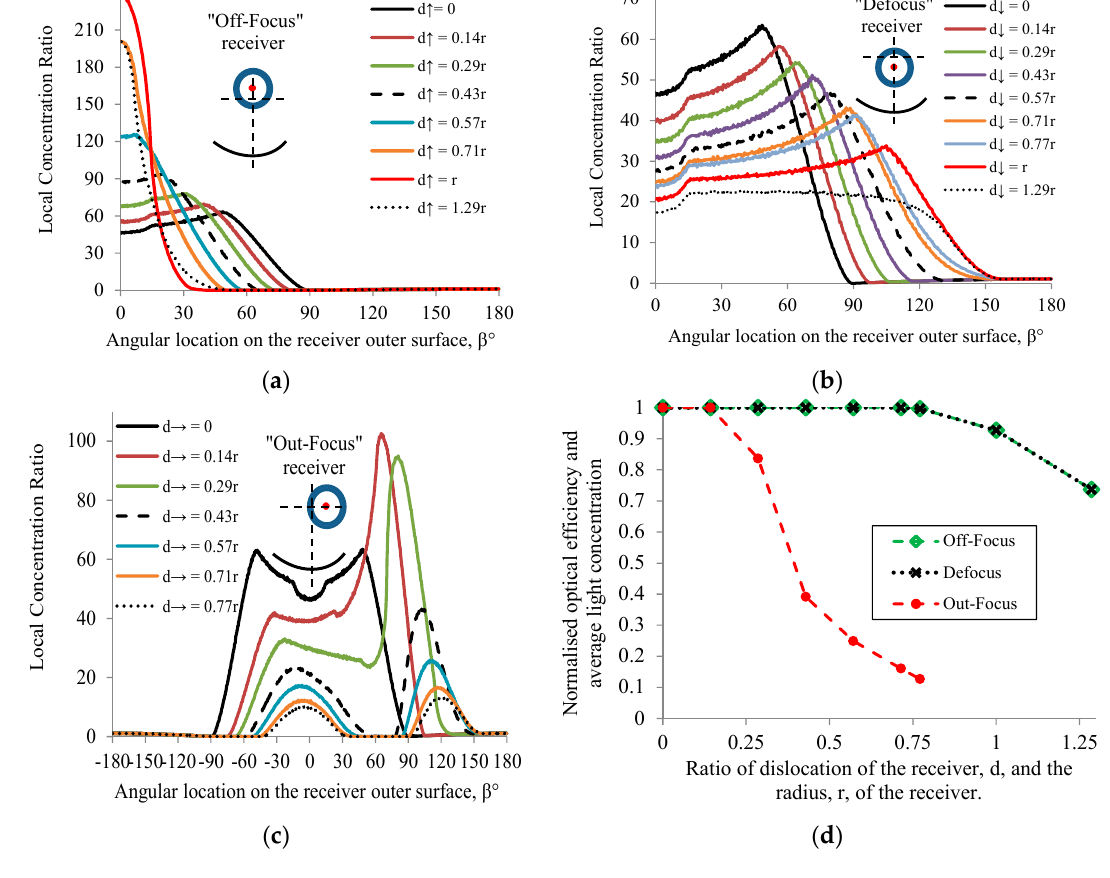
Figure 11. Effect of receiver dislocation on the LCR profile of the receiver: ( a ) off-focus; ( b ) defocus and ( c ) out-focus, and ( d ) on the η opt and C avg of the collector. (Here, ‘r’ is the radius of the receiver, ‘d’ is the amount of dislocation, and the arrows show the direction of dislocation). Table 3. Effect of collector operating conditions on the uniformity of the LCR distribution around the receiver of a PTC.